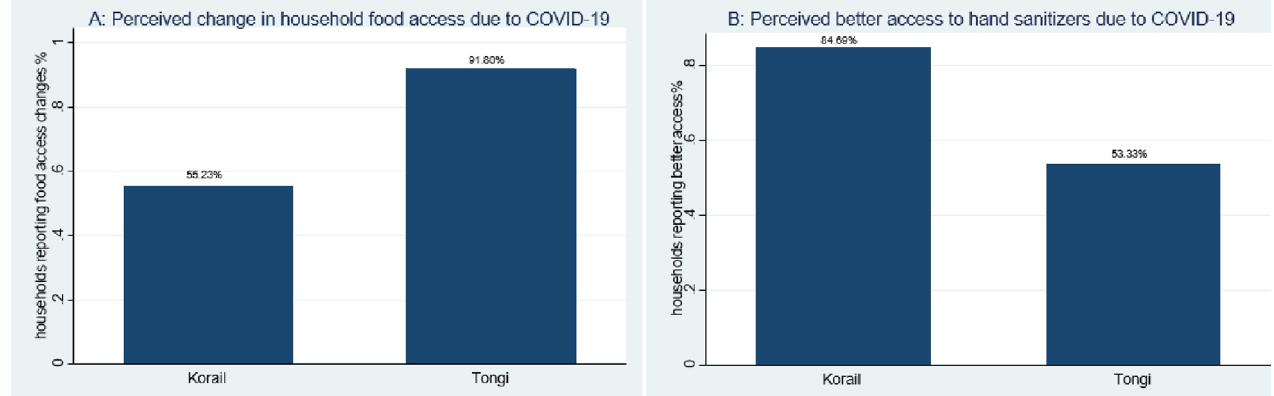
Fig 2. Perceived changes in household food security and hand hygiene due to COVID-19, by slum area.